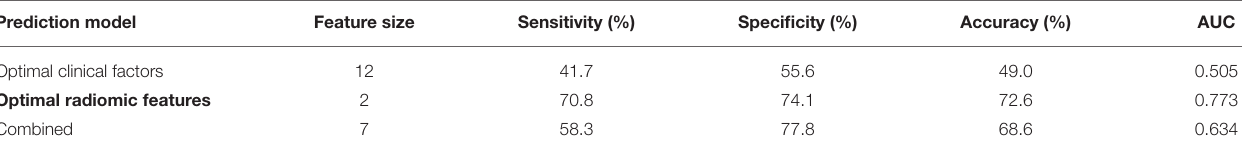
TABLE 2 | Discriminative capability of different nomogram models in MI prediction. Prediction